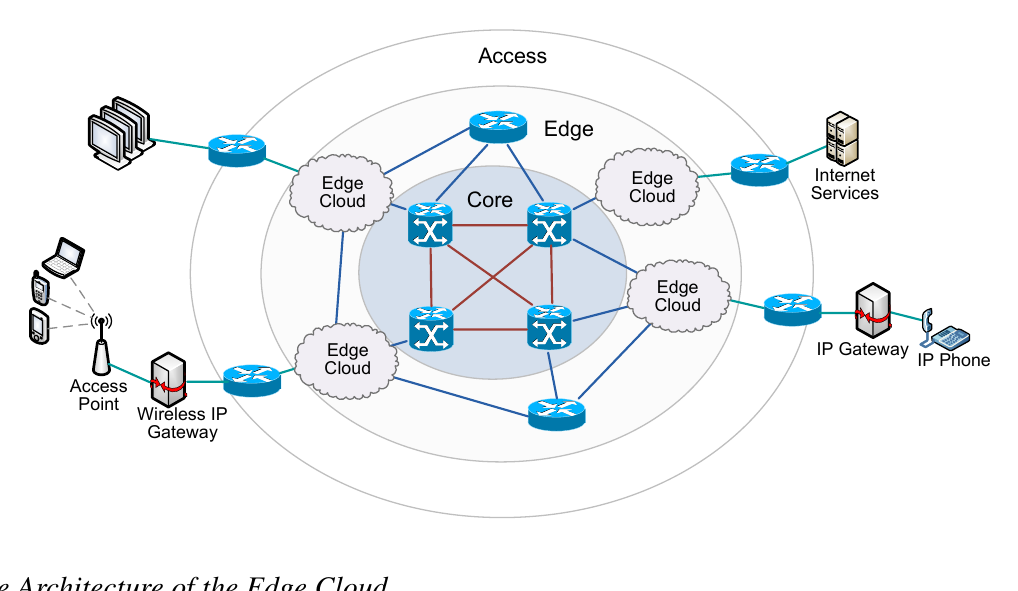
Figure 2. Edge Cloud-based next-generation Internet